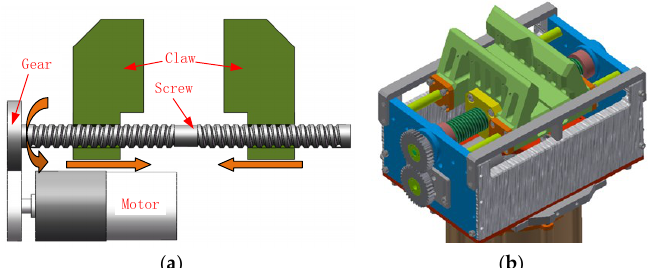
Figure 5. ( a ) The schematic diagram of mechanism of the claw; ( b ) The overall structure of the end effector.